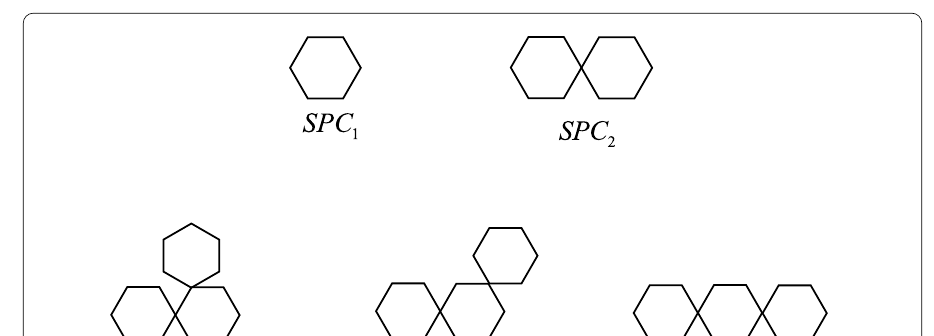
Figure 3 Spiro chains for n = 1,2,3